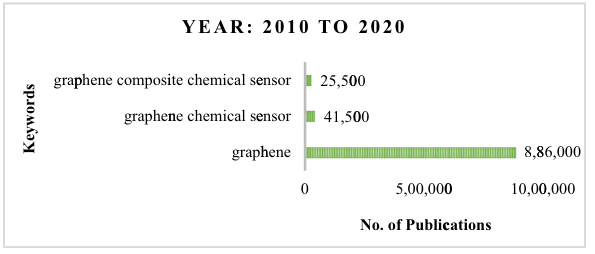
Figure 5: Progress of graphene - based chemical sensor in the last lytes detection was determined using equation ( 1 ) .